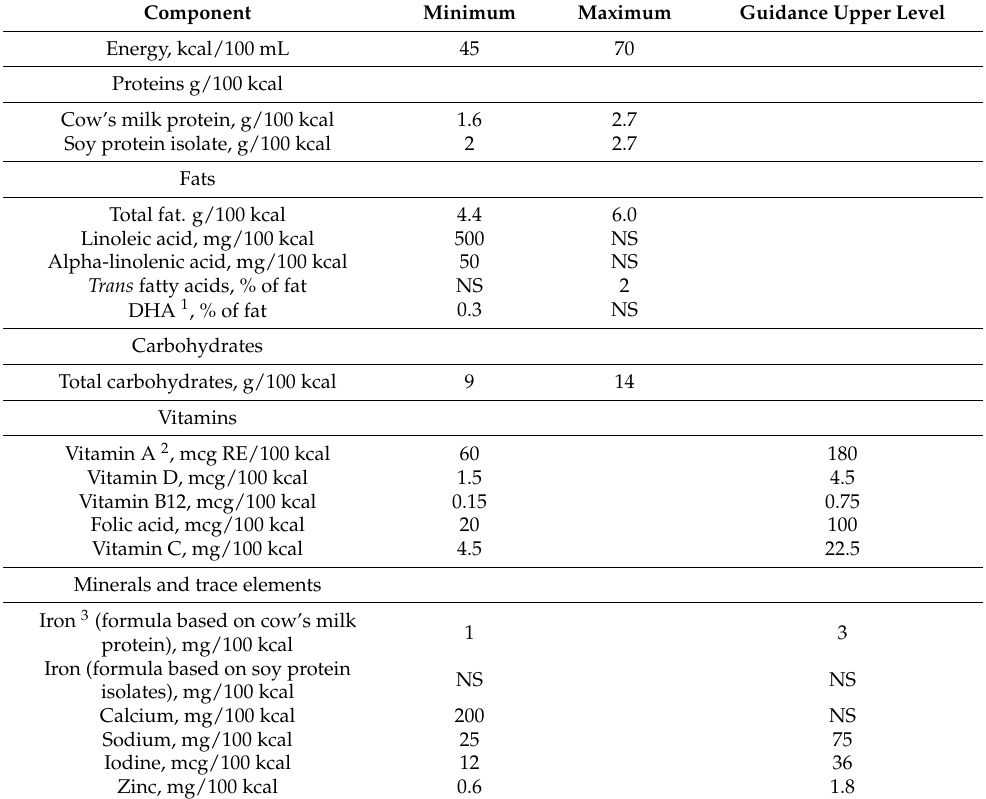
Table 4. Compositional requirements of young child formula for young children aged 12–36 months proposed by an International Expert Group co-ordinated by the Nutrition Association of Thailand and the Early Nutrition Academy. Modified from [21].